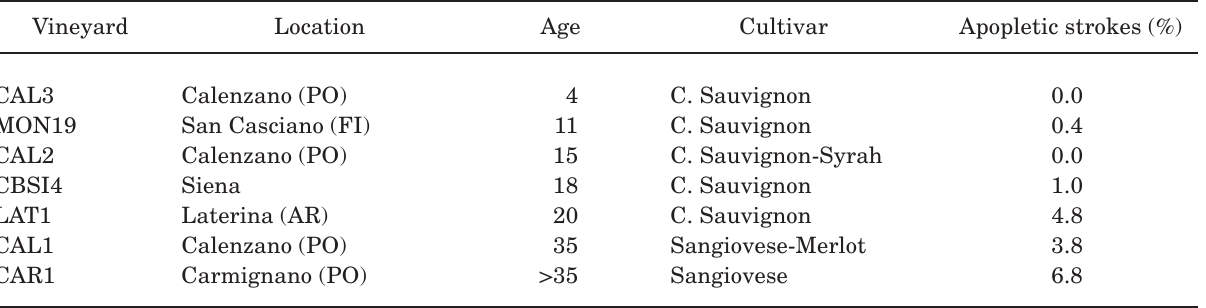
Table 5. Frequency of apoplectic strokes ([No. of apoplectic plants /No. of symptomatic plants] (cid:1) 100) in vineyards of varying age surveyed in Tuscany in 2005.